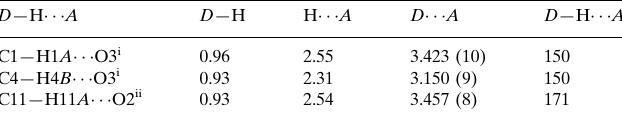
Hydrogen-bond geometry (A˚ , (cid:4)